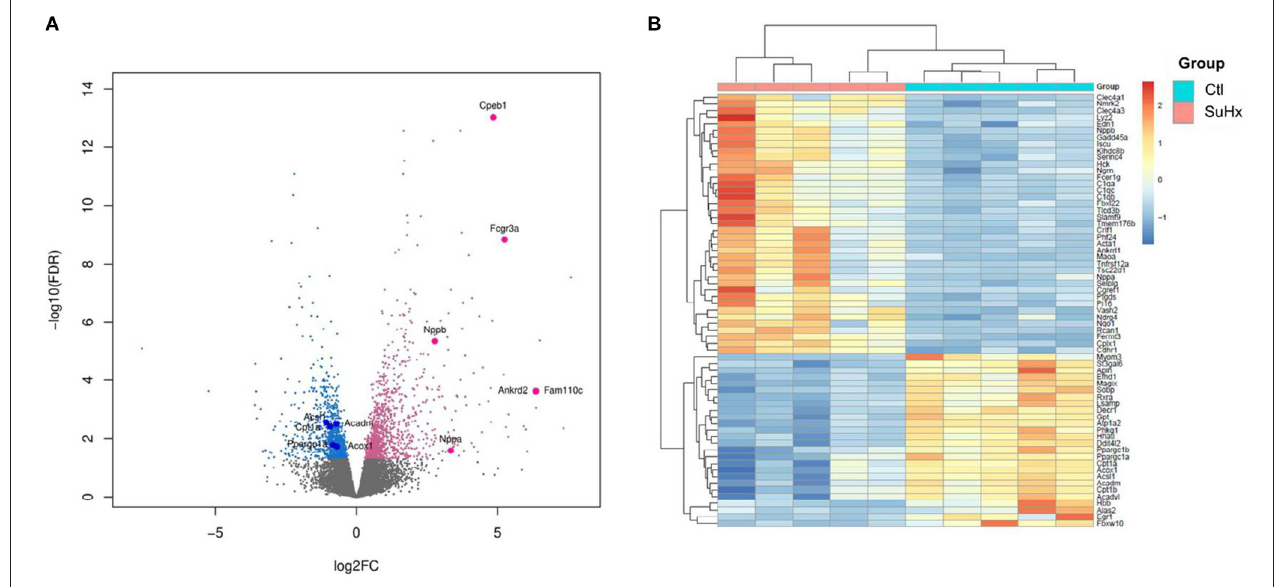
FIGURE 1 | Differential expression of RV genes reveals a distinct signature between Sugen 5416/hypoxia (SuHx) and control (Ctl) groups. (A) Volcano plot of the cardiac mRNA transcripts of the RV in the SuHx vs. Ctl groups. Significantly downregulated genes are in blue, significantly upregulated genes are in pink, nonsignificant genes are in gray. Highlighted, upregulated classic markers of ventricular hypertrophy and failure ( Nppa , Nppb ), downregulated genes involved in fatty acid metabolism ( Ppargc1a Cpt1a , Acadm , Acox1 , and Acsl1 ), and upregulated genes that were used for RNA sequencing validation ( Ankrd2 , Fam110c , FCGR3a , and Cpeb1 ). (B) Z -score heatmap of 65 significantly differentially expressed genes related to metabolic pathways between SuHx and control groups, n = 5 individual animals per group. For experimental design (see Supplementary Figure 1 ).